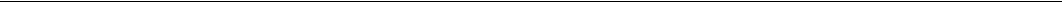
Figure 1 | The mutational spectrum of TSC1 and TSC2 in TSC patient samples. ( a ) SNVs and INDELs in TSC2 and TSC1 (each mutation shown only once per patient). ( b ) Large TSC2 deletion in 10-RA1 identified by SNP array. Black dots: log-R ratios (LRR) of probe intensities; lower panel: magnification of boxed region. ( c ) Intragenic TSC2 deletion in 63-UG1 identified by targeted sequencing; grey bars: read counts along TSC2 ; blue bars: exons. ( d ) Blue bars: large deletions in TSC2 . X-axis is broken to accommodate 32-SEGA1 deletion. ( e , f ) Example CN-LOH events as involving TSC1 on chromosome 9q in 38-SEGA1 ( e ) and TSC2 on chromosome 16p in 27-SEGA1 ( f ). ( g ) Percentage of 66 TSC patients with a mutation in TSC1 , TSC2 or neither (NMI). ( h ) Percentage of tumours with 1 or 2 TSC1/TSC2 mutations identified. ( i ) Percentage of TSC1/TSC2 mutant tumours with 2 hits. Only 1-hit lesions with all 3 DNA platforms completed included (Supplementary Data 2). ( j ) Percentage of germline and somatic TSC1/TSC2 mutations of each type. ( k ) Total number of TSC1/TSC2 mutations of each class for each lesion type. ( l ) Combinations of mutations in TSC1 and TSC2 mutant tumours. ( m , n ) Relative TSC2 ( m ) and TSC1 ( n ) mRNA expression in non-TSC tissues ( n ¼ 11) and TSC lesions grouped by mutational status ( TSC2 mutation: 1 ( n ¼ 11) or 2 ( n ¼ 14);